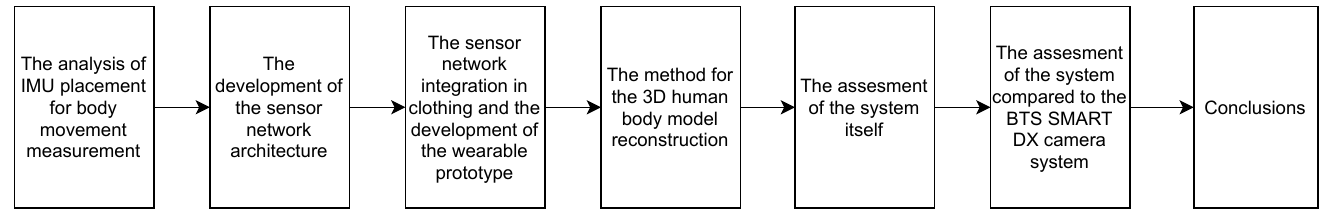
Figure 1. Flowchart of the proposed